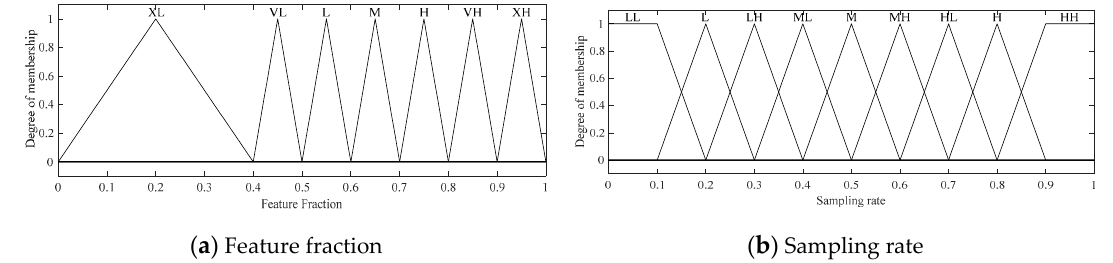
Figure 8. Two fuzzy input variables for the fuzzy BCS-SPL algorithm: (LL = Low Low, L = Low, LH = Low High, ML = Medium Low, M = Medium, MH = Medium High, HL = High Low, H = High, HH = High High, XL = Extremely Low, VL = Very Low, L = Low, M = Medium, H = High, VH = Very High, XH = Extremely High).